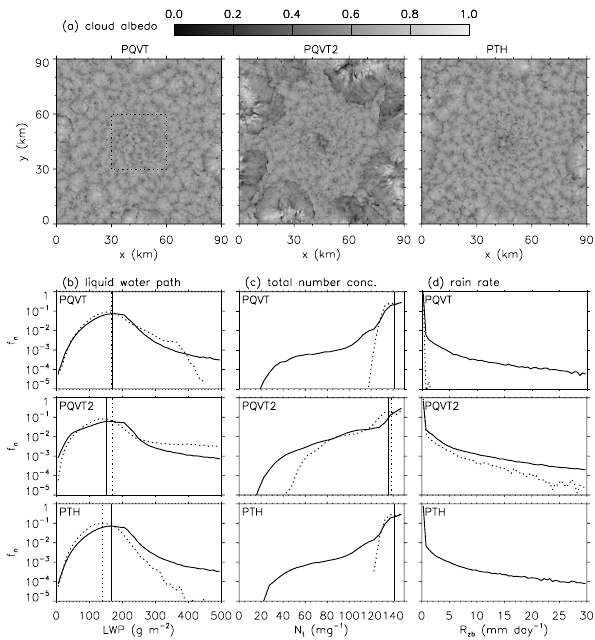
Fig. 6. Same as Fig. 5 but for experiments PQVT, PQVT2 and